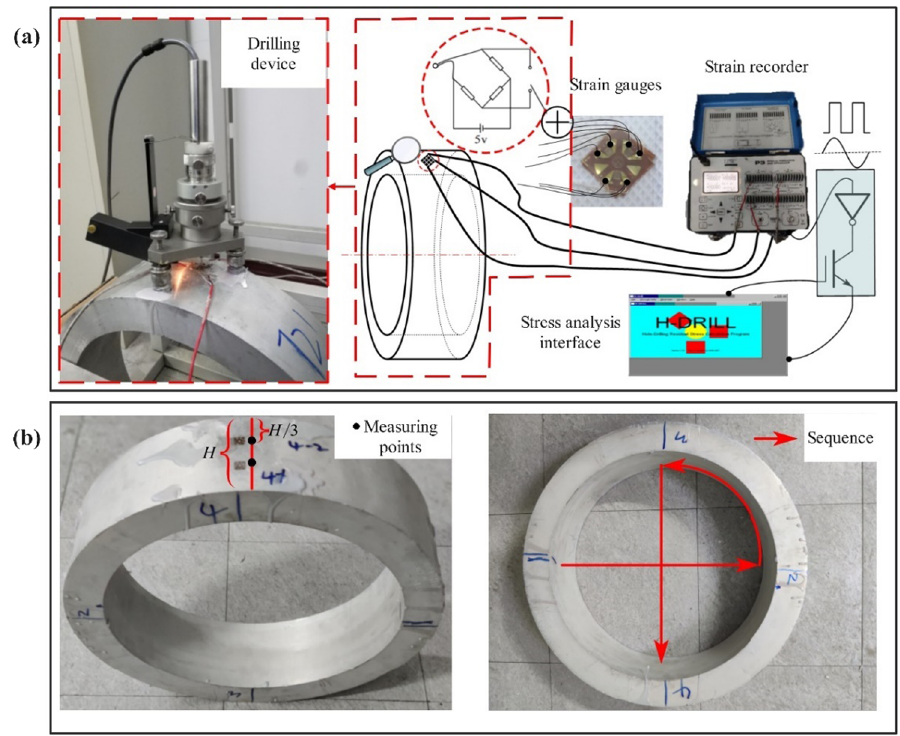
Figure 3: Scheme of ( a ) residual stress measuring system and ( b ) measuring